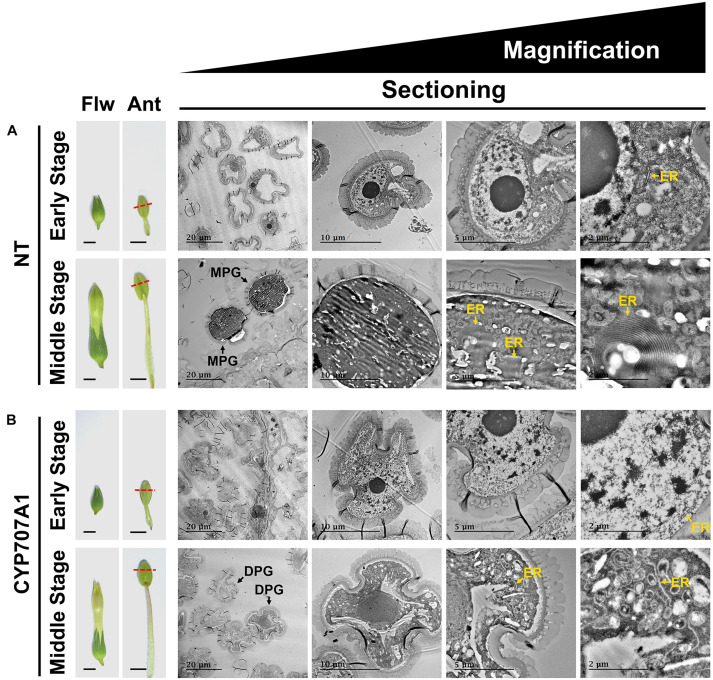
Suppressed pollen maturation in 35S:CaCYP707A1 plants. (Left) Images of flowers (Flw) and anthers (Ant), and (right) ultrastructure of the pollen formed in NT (A) and 35S:CaCYP707A1
(B) plants as shown by ultra-thin sections and TEM. CYP707A1 indicates 35S:CaCYP707A1 transgenic plants (line #1), and red dashed lines mark the longitudinal positions from which the slices were obtained. Yellow arrows indicate the ER membrane. Ant, anther; DPG, degenerated pollen grain; ER, endoplasmic reticulum; Flw, flower; MPG, mature pollen grain. Scale bars = 0.5 cm in flower; 0.2 cm in anther; and (left to right) 20, 10, 5, and 2 μm in TEM images. Two individuals of the indicated plants were analyzed, and the experiments were performed two times with similar results.